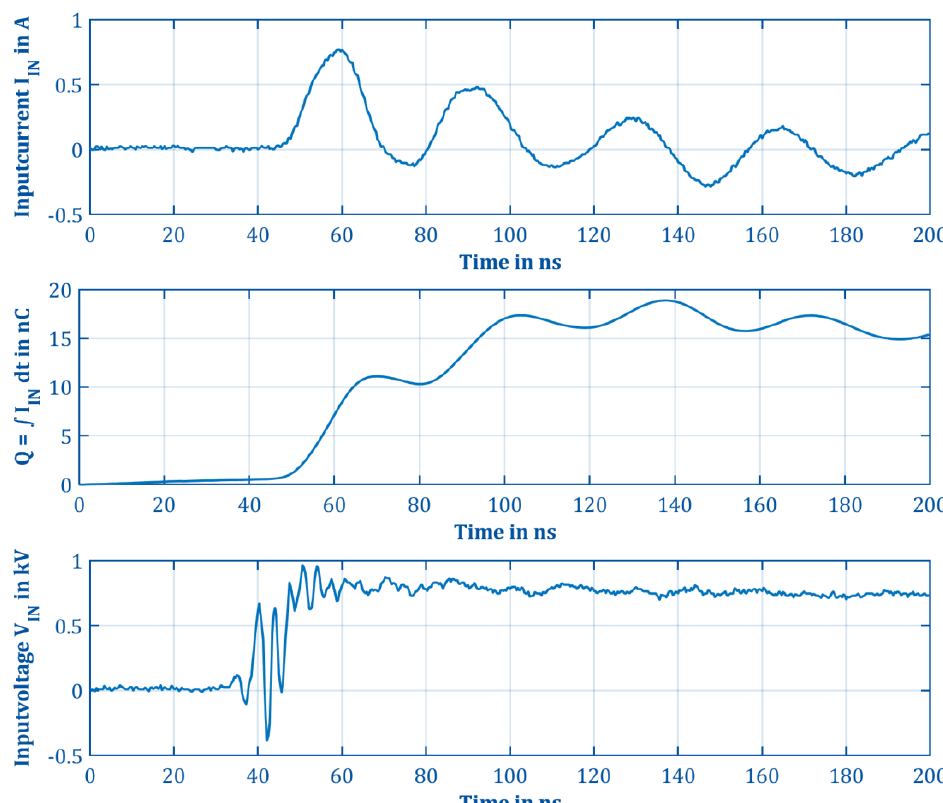
PHV 1000, and developed resistive voltage divider) for simultaneous measurement of the high- voltage step.